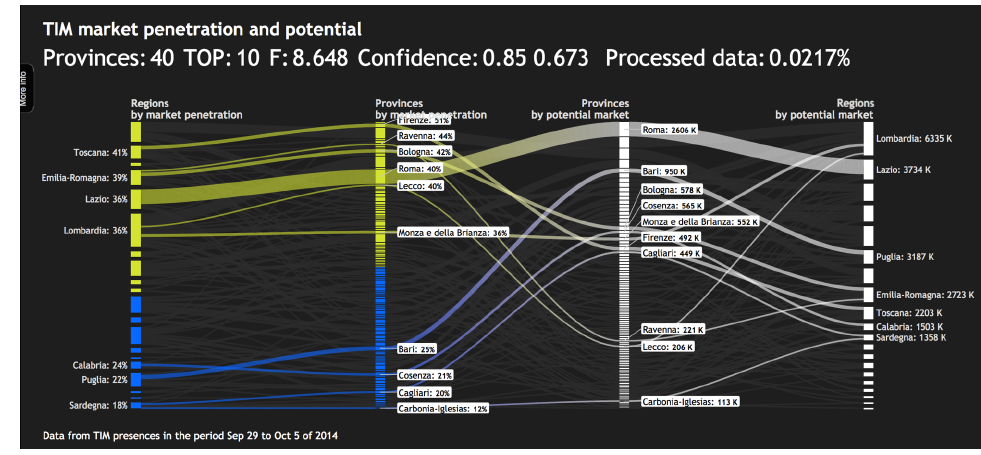
Figure 4. The currently best Top-10 set of provinces is highlighted at the top of the parallel-Sankey plot. The user can easily distinguish provinces above the market penetration median (yellow) and those below (blue). The numerical quality indicators above the plot help the analyst judge the current result: The first confidence value of 0.85 means that between 8 and 9 provinces of the current Top-10 are already stable. The second confidence value shows that the current result is at 0.673 of the optimal result—i.e., if the analyst waits for the remaining two provinces of the Top-10 to stabilize, the estimated gain to the current objective function F = 8.648 will still be more than 30%. Putting these values in relation to the small fraction of only a 2/10000th of all combinations having been tried yet, the current result looks already quite good, but leaves room for further